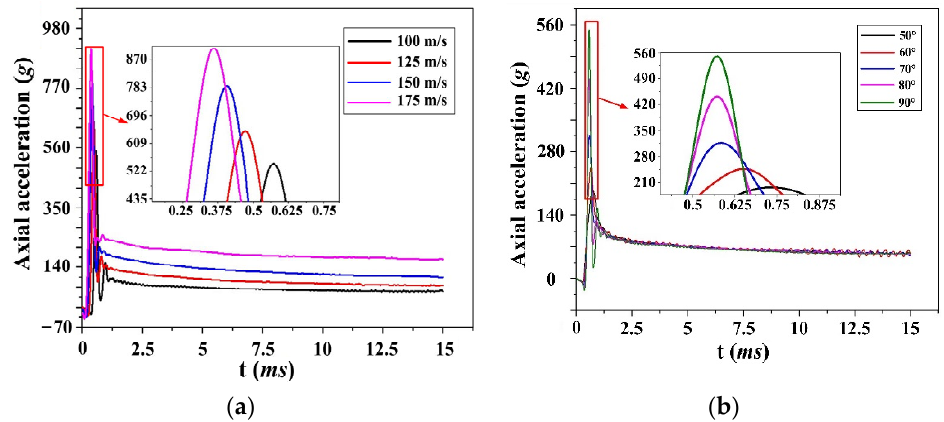
Figure 8. Axial acceleration. ( a ) Different velocities with angle of 90°. ( b ) Different angles with velocity of 100 m/s.